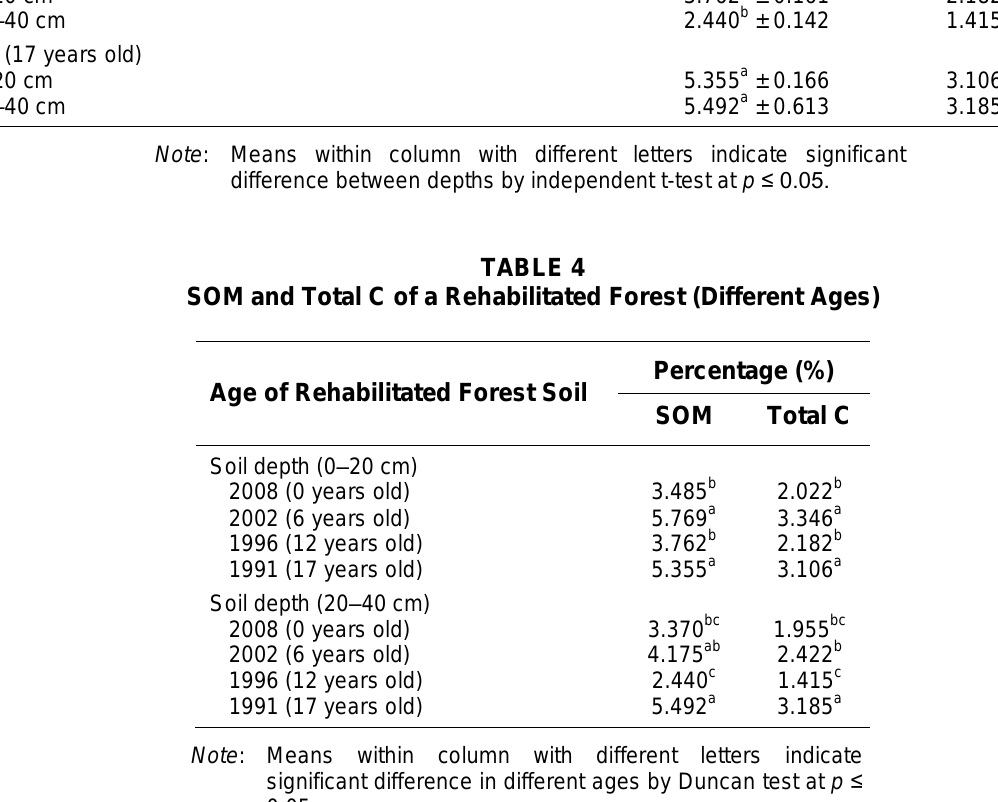
SOM and Total C of a Rehabilitated Forest (Different Ages)